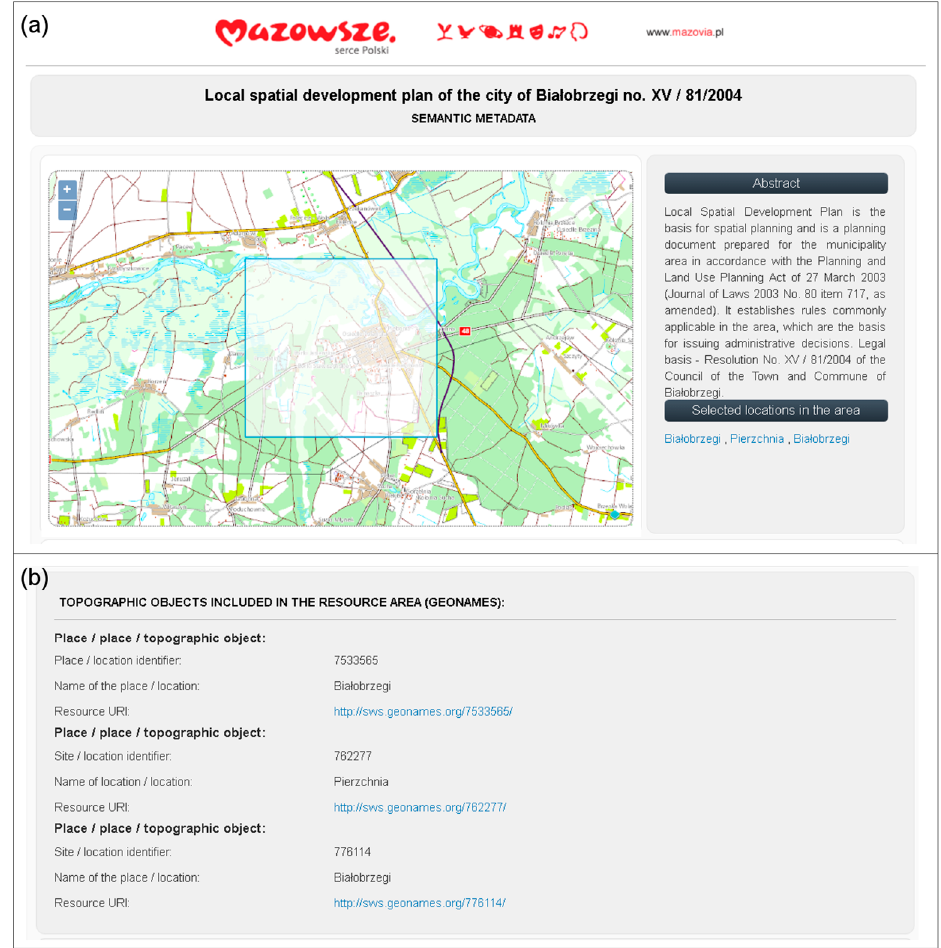
Figure 6. Fragments of HTML document, containing metadata for local spatial development plan: ( a ) title, basic information and bounding box of data; ( b ) links to Geonames features, included in the resource area.